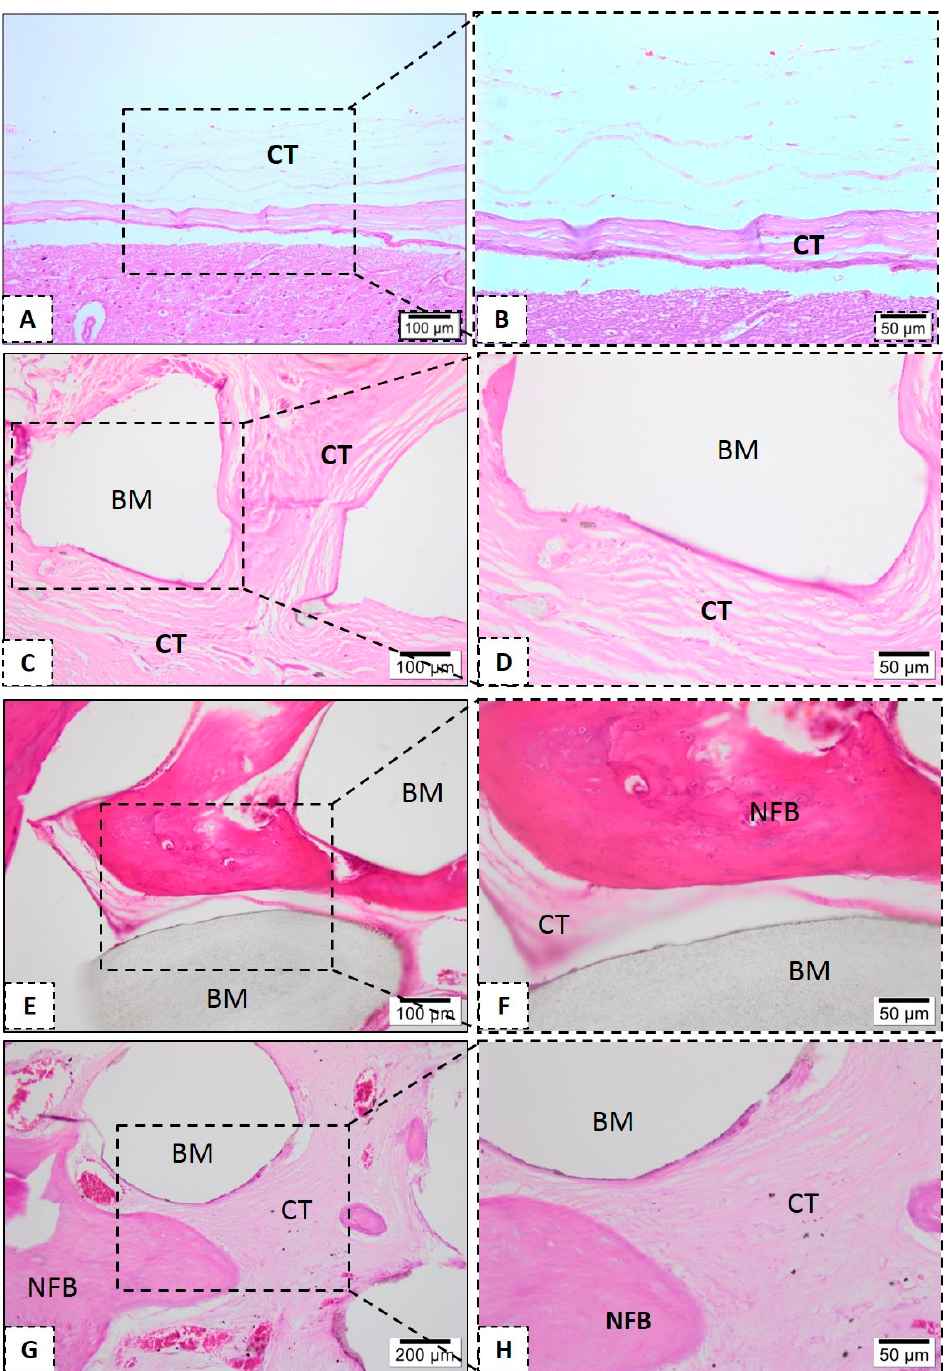
Figure 11. Representative photomicrographs of calvaria defect after 3 month. Histological section stained with hema- toxylin/eosin from the region of control without biomaterial ( A , B ), biomaterial implantation in the PLA ( C , D ), PLA-CaP ( E , F ) and PLA-CaP-rhBMP-2 ( G , H ) groups—3 month after implantation. The region occupied by pre-existing bone is indicated with (PEB), newly formed bone (NFB); connective tissue (CT) and biomaterial/PLA scaffold (BM). Results are representative of 5